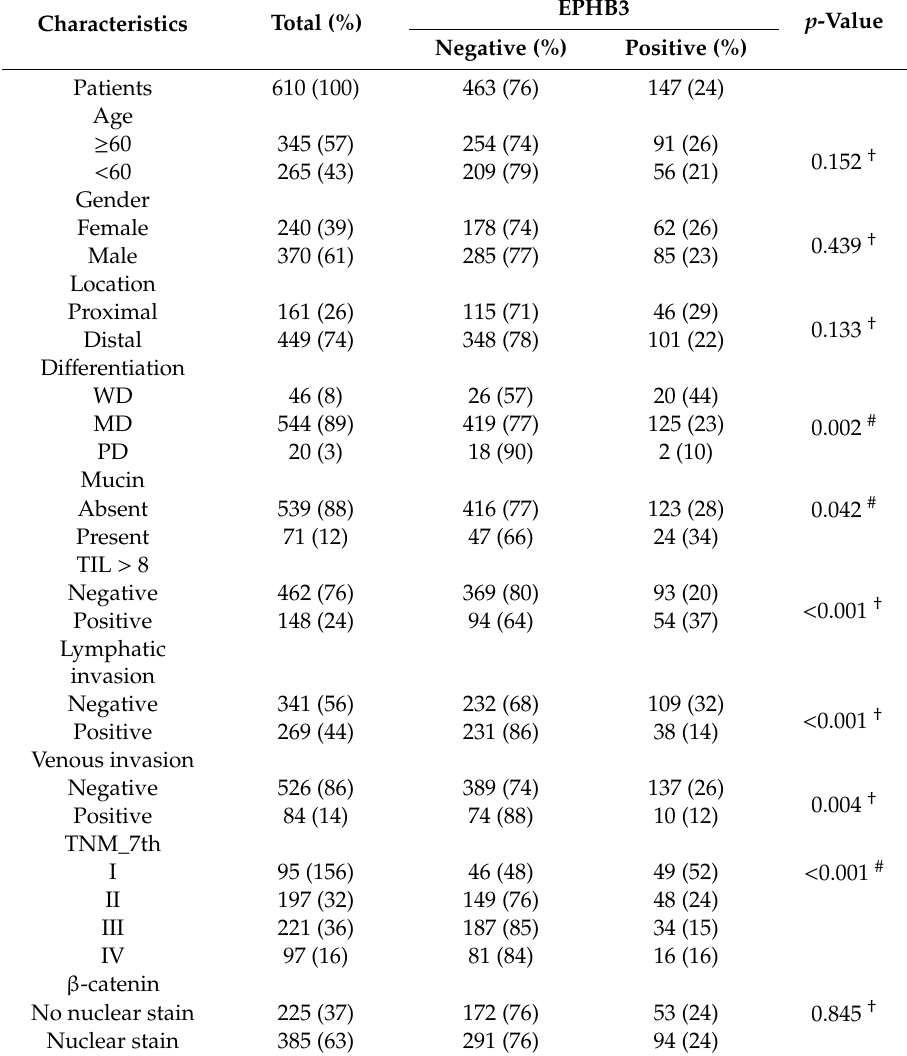
Table 1. Association between EPHB3 expression and the clinicopathological characteristics.